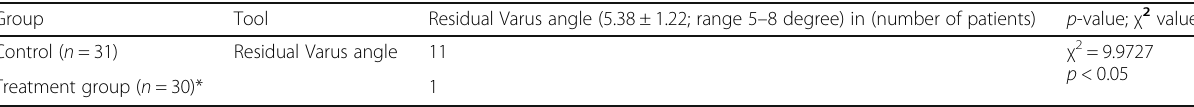
Table 3 Residual varus alignment Group